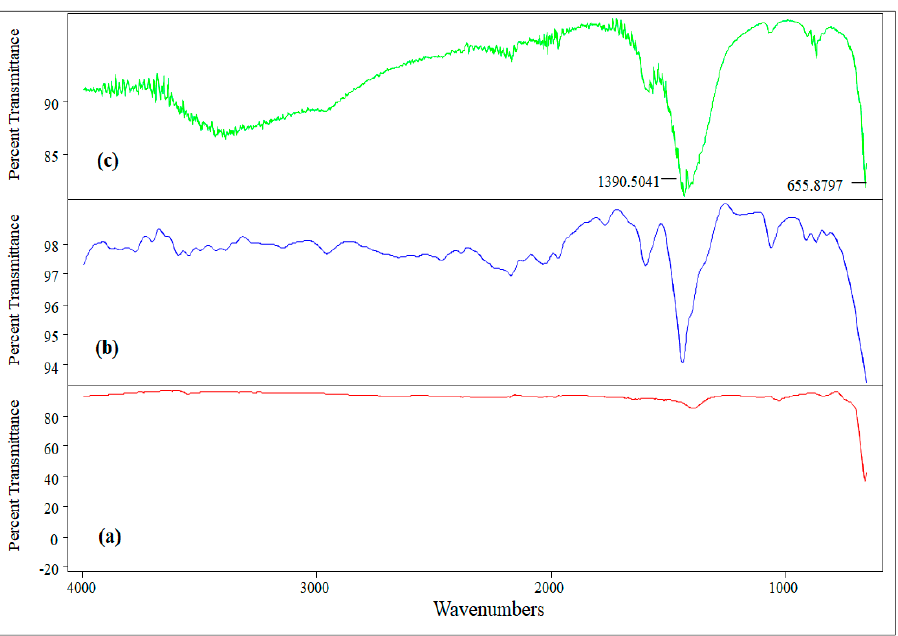
Figure 2. FTIR spectrum of ( a ) bismuth oxide Bi 2 O 3 (NC1), ( b ) Bi0.8Ce0.2 nanocomposite oxide (NC2), ( c ) Bi0.5Ce0.5 nanocomposite oxide (NC3).